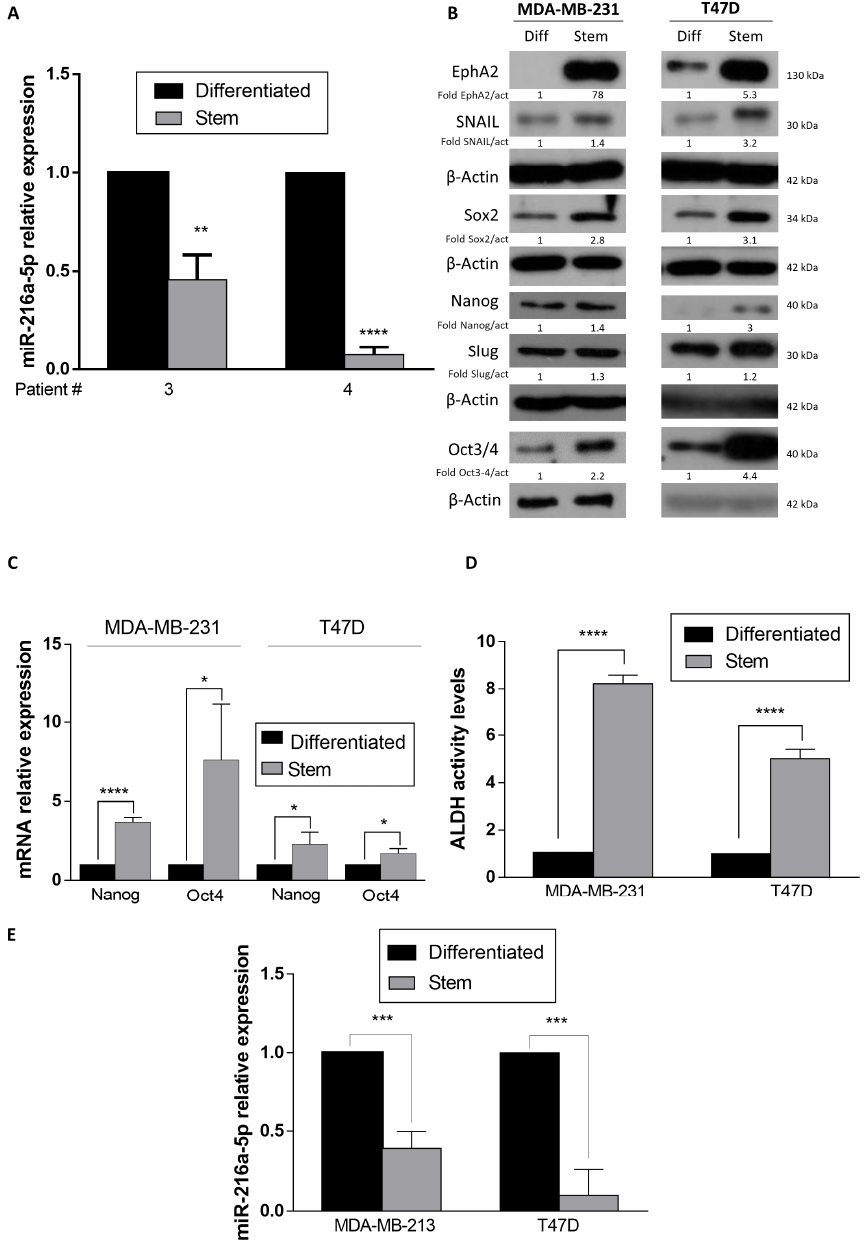
Figure 1. MiR-216a-5p expression in breast cancer stem cells (BCSCs). ( A ) MiR-216a expression levels were analyzed by qRT-PCR in primary breast cancer cells cultured in suspension (stem cells) or adherent (di ff erentiated cells) conditions. ( B ) MDA-MB-231 and T47D stem cells express higher levels of stem markers compared to di ff erentiated cells, as assessed by Western blotting. ( C ) MDA-MB-231 and T47D stem cells express high levels of Oct4 and Nanog , as assessed by Real-time PCR. ( D ) MDA-MB-231 and T47D stem cells have high levels of ALDH activity, as assessed by flow cytometry. ( E ) MiR-216a is down-regulated in enriched stem cell cultures. Data are mean values ± SD of three independent experiments. Significance was calculated using Student’s t-test. *, p < 0.05, **, p < 0.01, ***, p < 0.001, ****, p <